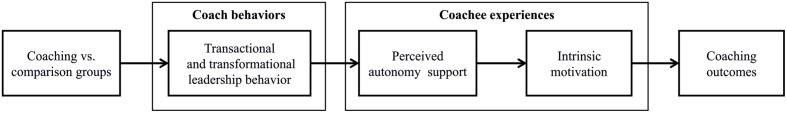
Proposed theoretical model illustrating that the influence of a coach’s leadership behavior on a coachee’s experiences (perceived autonomy support and intrinsic motivation) has an effect on coaching outcomes.